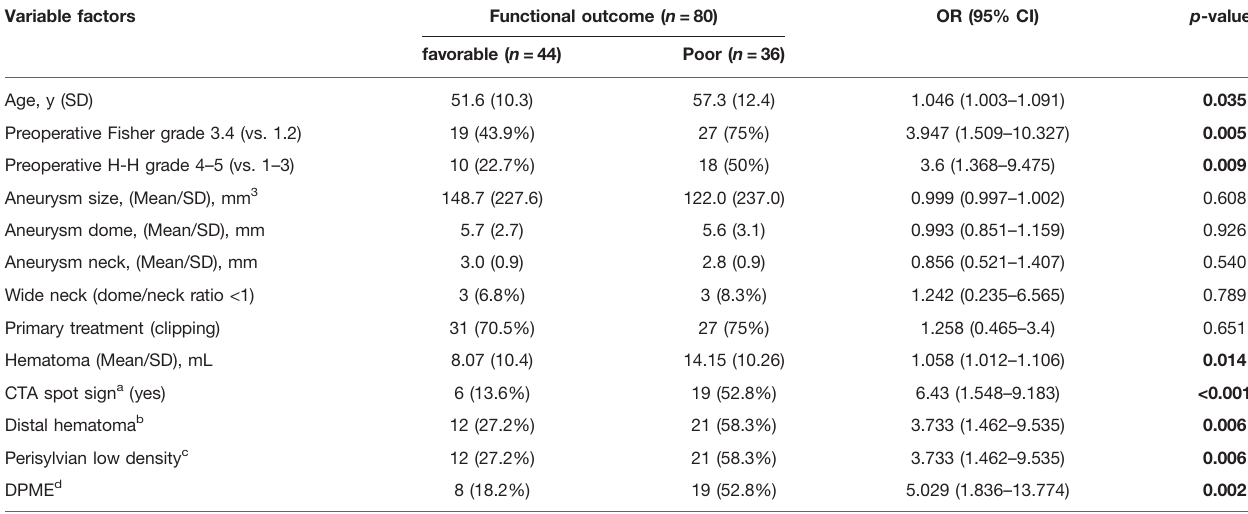
TABLE 5 | Outcome predictors after aSAH caused by ruptured MCA aneurysm. Variable